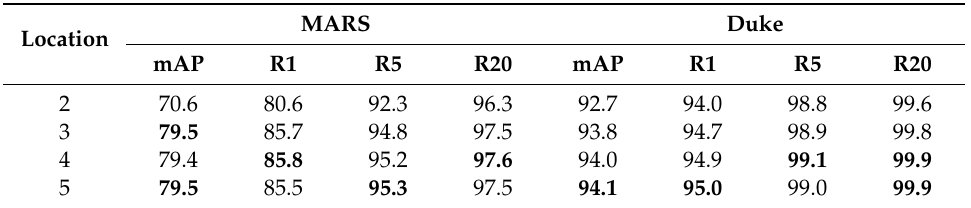
Table 3. Evaluation of the e ff ect of inserting a single NLAM layer after di ff erent CNN blocks. The number in the location column represents adding the NLAM layer after this CNN block.